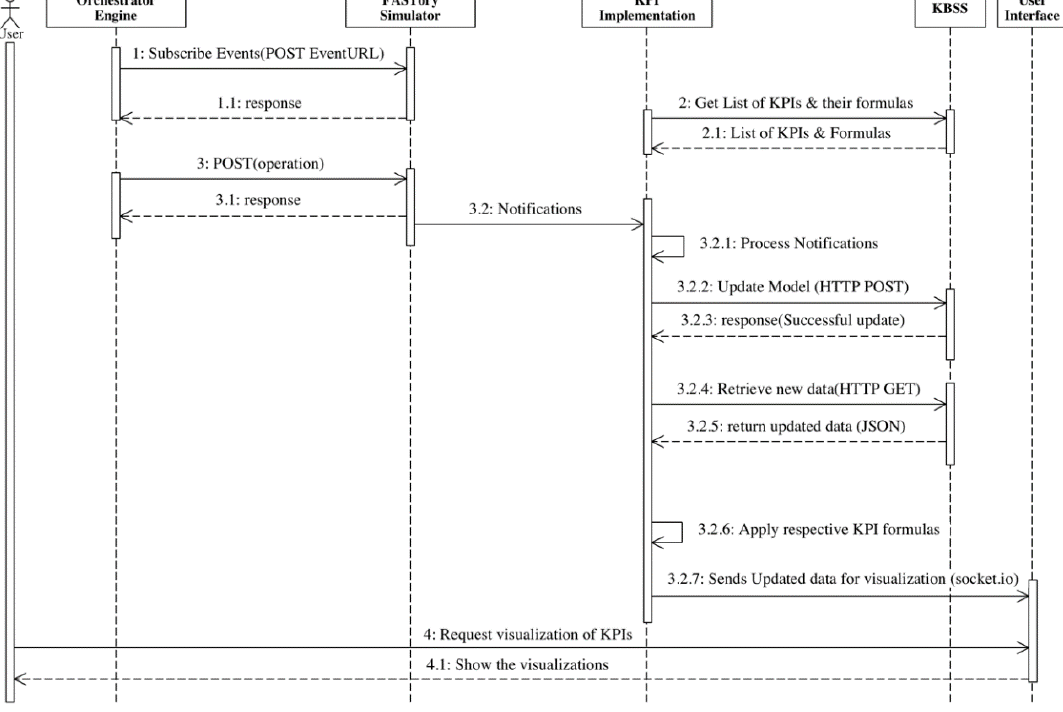
Figure 10. UML sequence diagram of components interaction for KPI visualization.